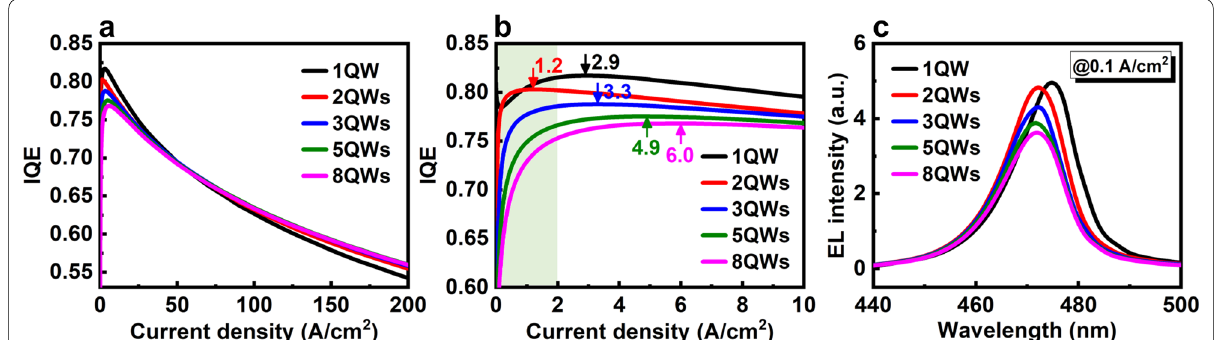
Fig. 5 a IQE curves and b IQE curves at low current density of LED with 8, 5, 3, 2, and 1 QWs. c EL spectra of LED with 8, 5, 3, 2, and 1 QWs at 0.1 A/ cm